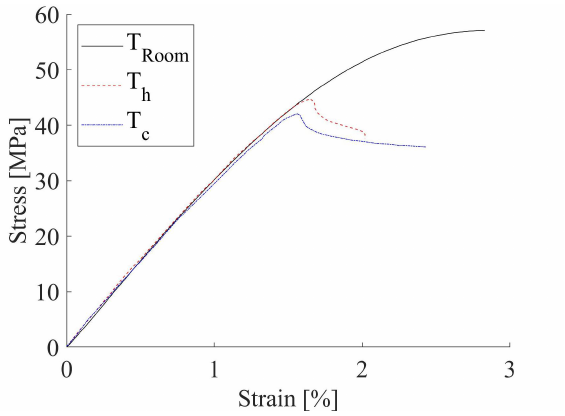
Figure 4. Tensile curves of 0° specimens thermally treated and